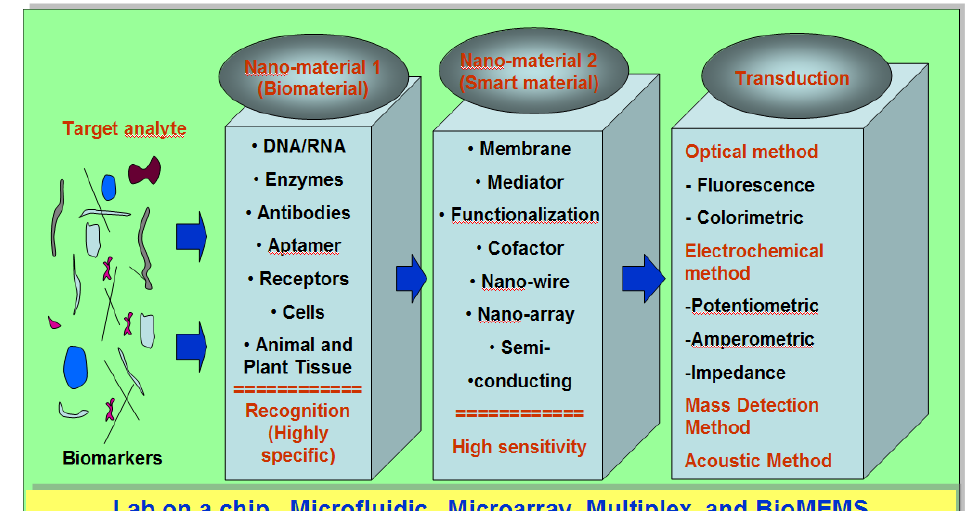
Figure 1. Outline for the development of nanomaterial-based